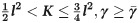
The retailer's profit and utility with α in 12l2<K≤34l2,γ≥γ¯.